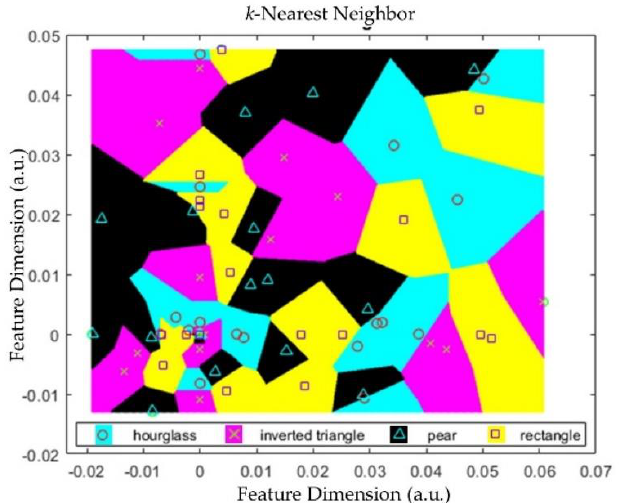
Figure 9. The k- nearest neighbor algorithm for body shape classification. The bag-of-features descriptors are mapped in 2 dimensions in the figure, each cluster center pointing to one visual word using k-means clustering, and the k- nearest neighbor is used for generating the histogram of visual words.